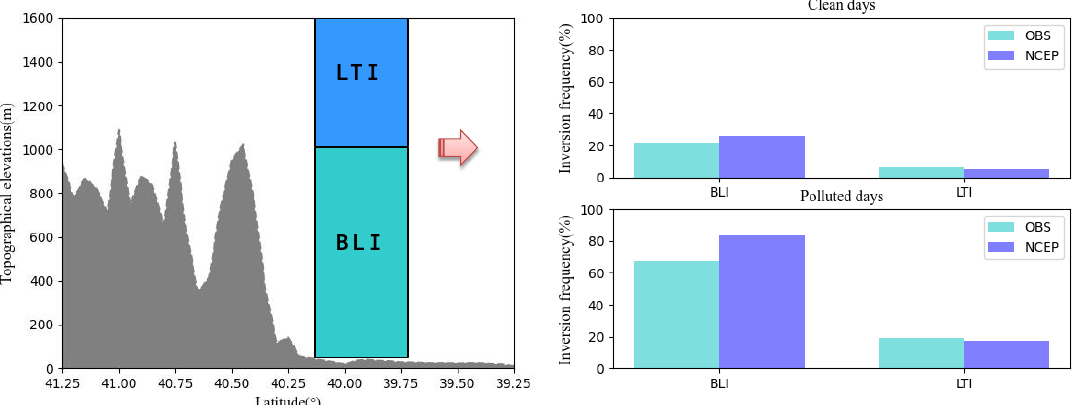
Figure 9. Topographical cross-section of Beijing and surrounding areas along 116.5 ◦ E, as well as the temperature inversion frequencies of the observations and the NCEP/FNL reanalysis data during the clean days and polluted days.